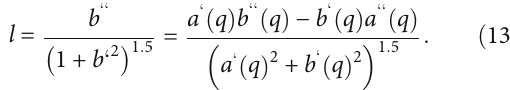
Figure 3 is a schematic diagram of the tangent vector and the normal vector of the curve.